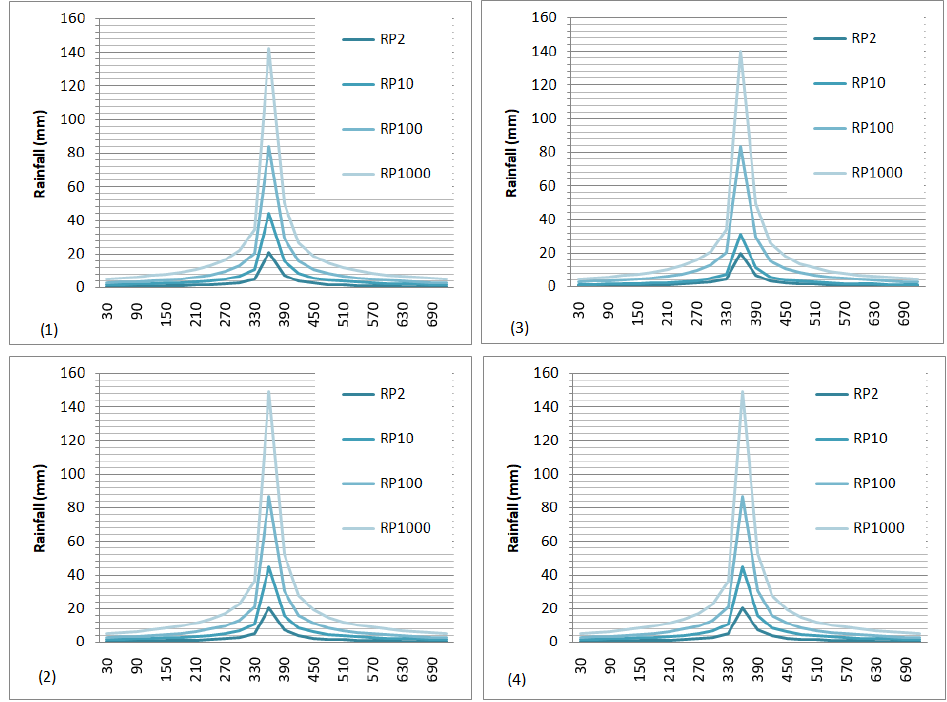
Figure 3. Hyetographs for sub-basin LP1 ( 1 ), sub-basin LP2 ( 2 ), sub-basin LP3 ( 3 ), and sub-basin LP4 ( 4 ), and different return periods (RP) in years.